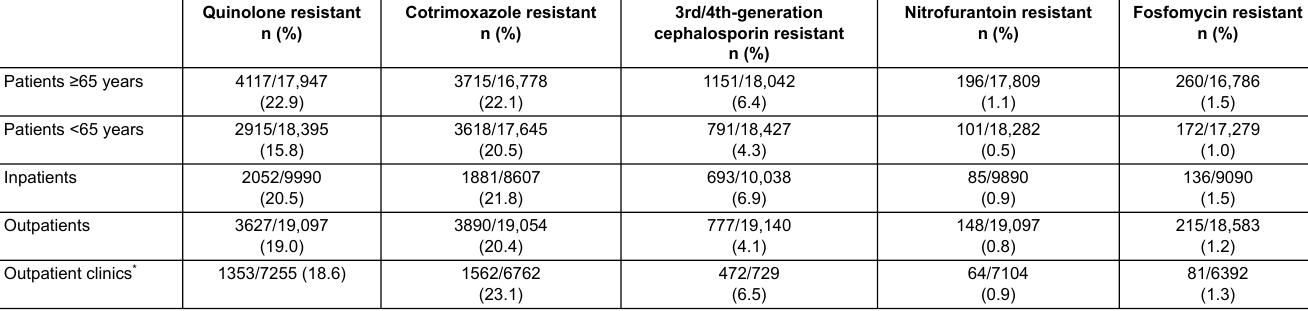
Table 4: Resistance of E. coli isolates in 2016 according to age group and